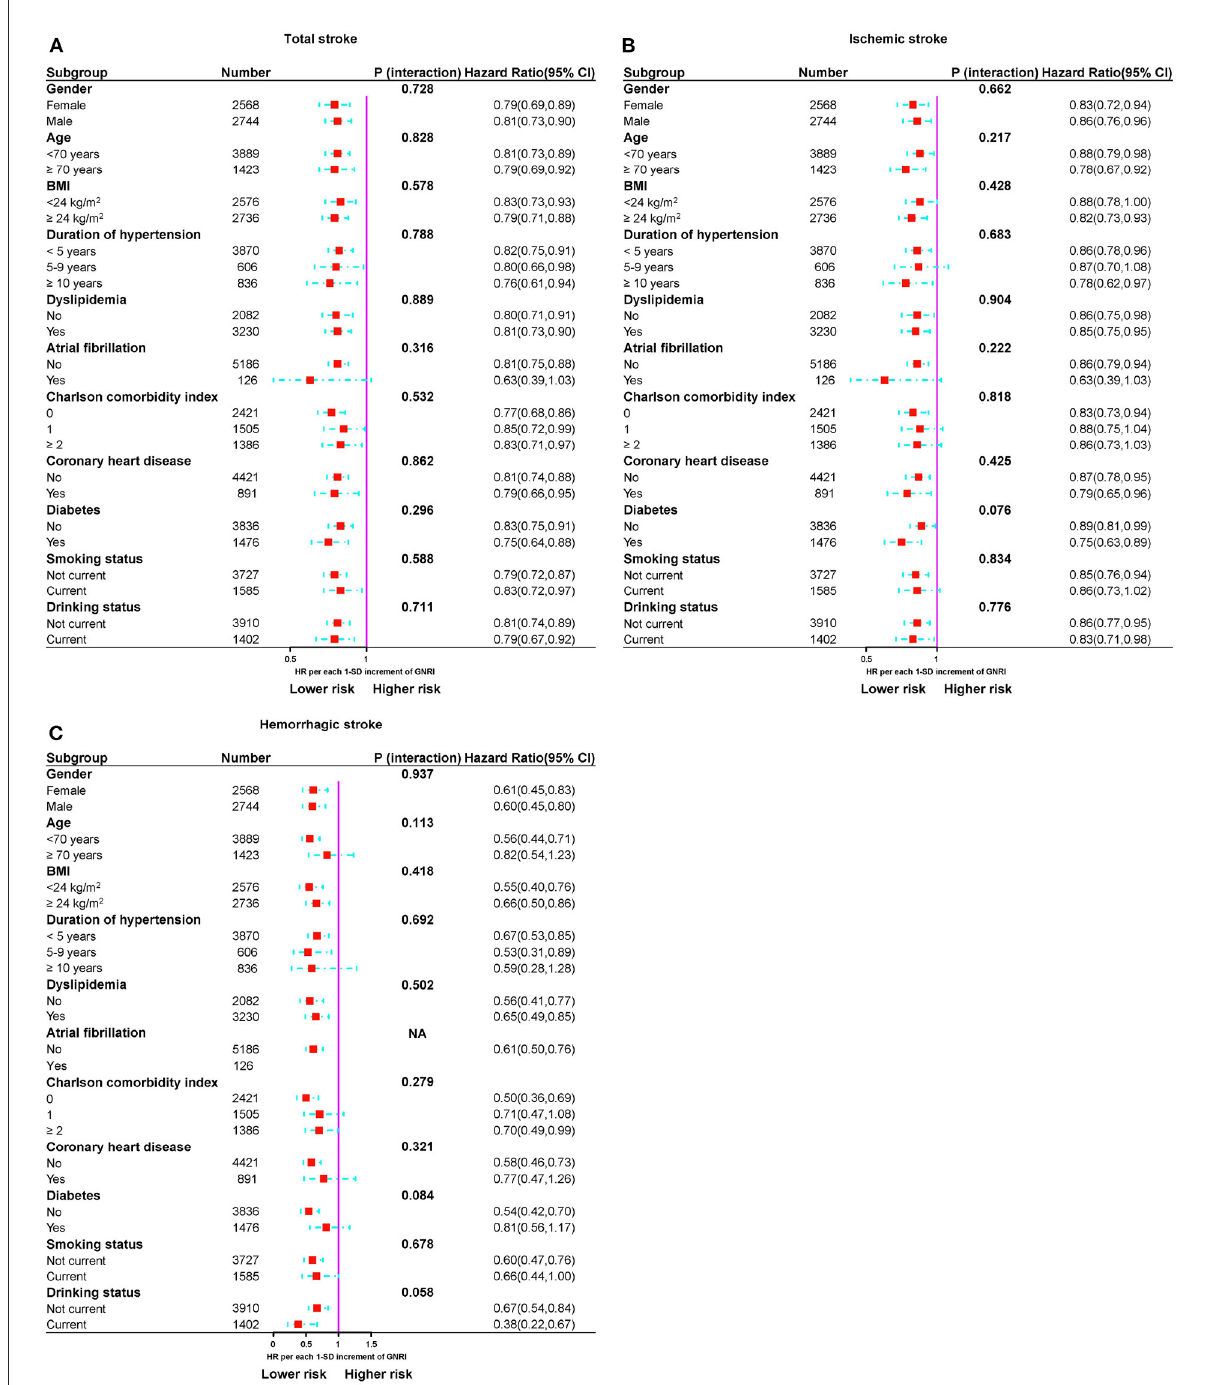
FIGURE5 Subgroup analyses of the relationship between GNRI and risk of stroke events. (A) Total stroke, (B) ischemic stroke, and (C) hemorrhagic stroke.